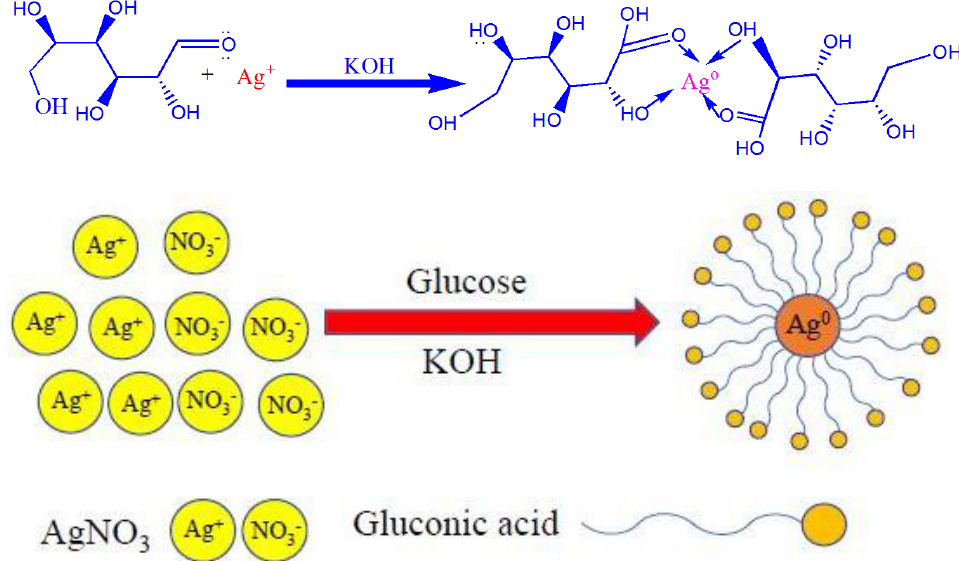
Scheme 2. Possible route for the synthesis of